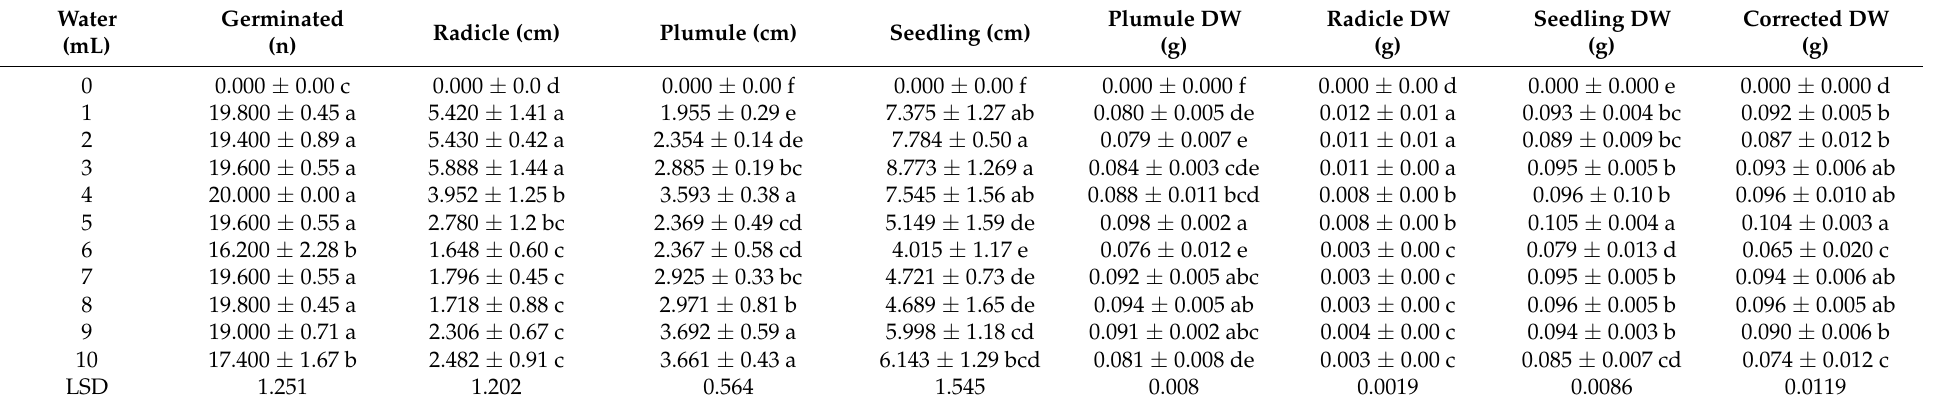
Table 1. Mean data on germination and seedling growth traits for the different amounts of water based on one-milliliter intervals.